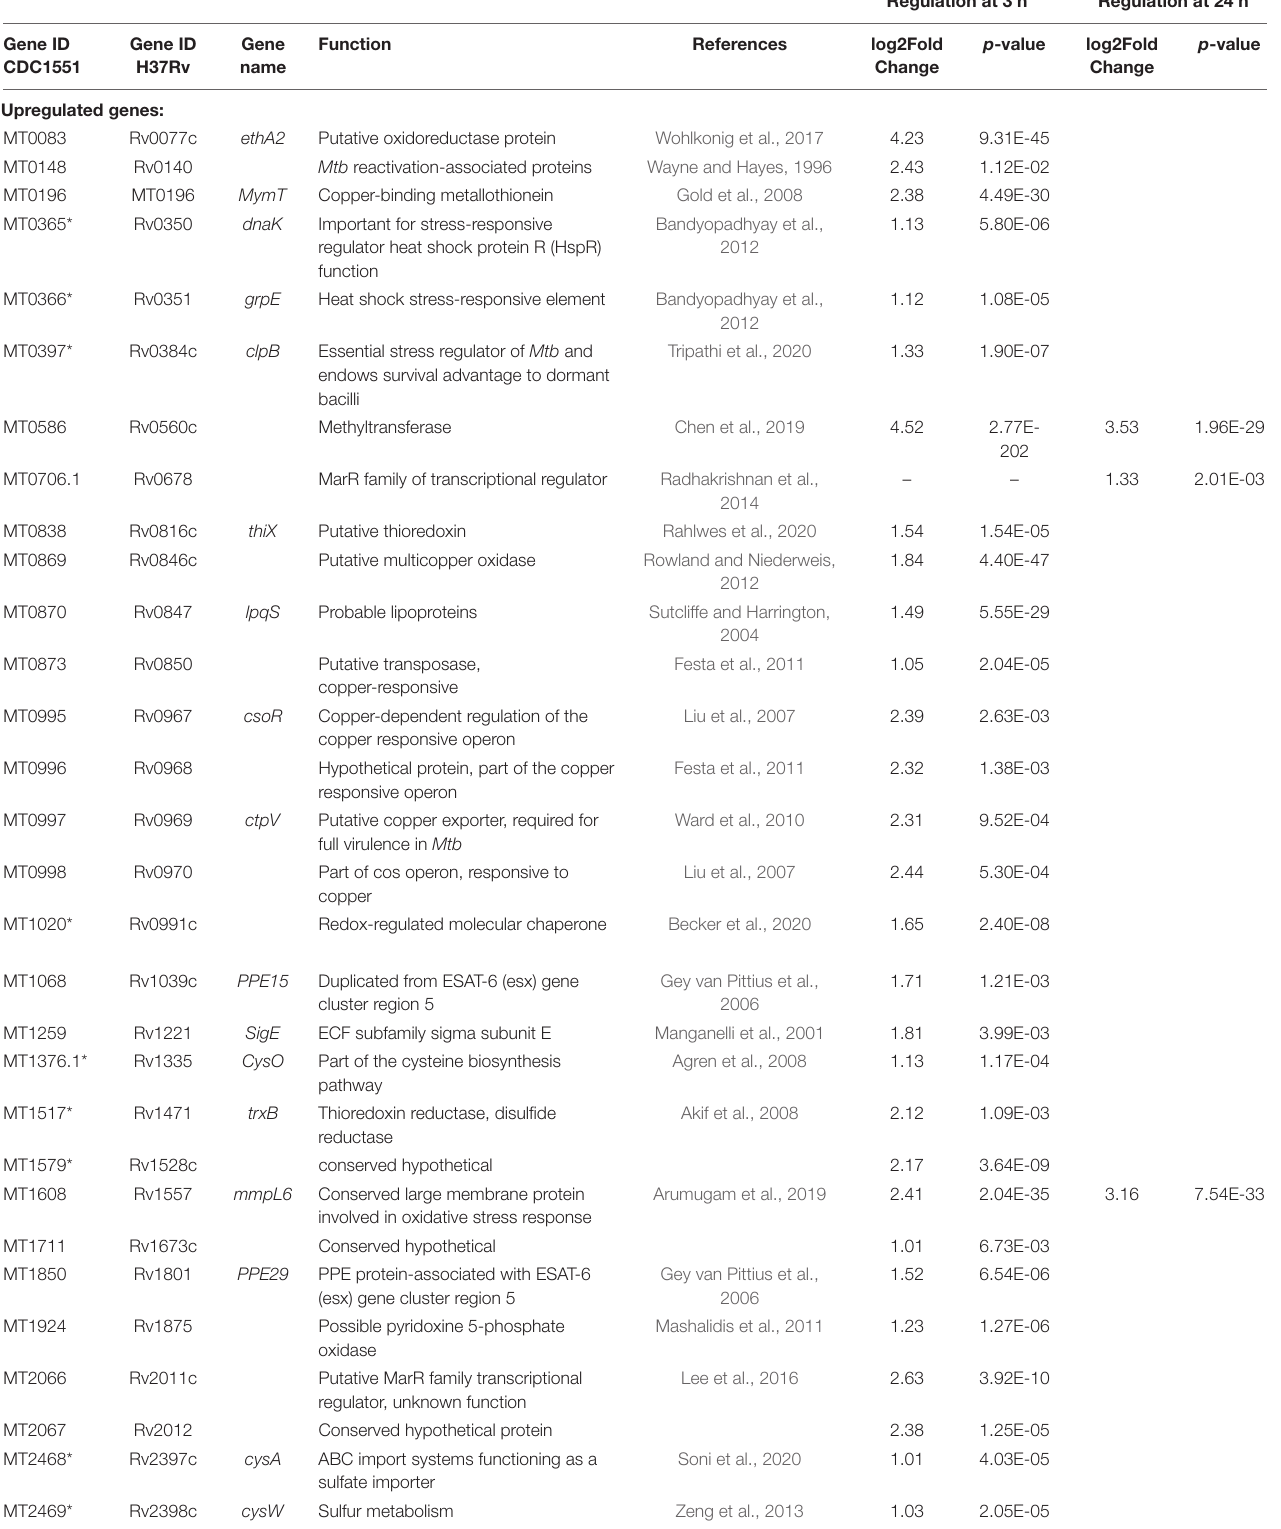
TABLE 2 | Genes differentially expressed in Mtb after 3 and 24 h of CSC